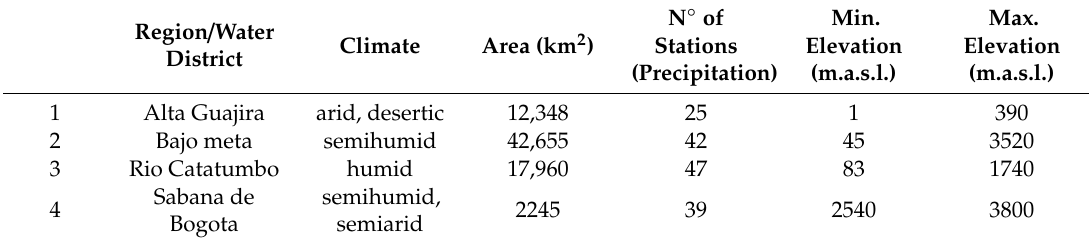
Table 1. Characteristics of the four analyzed